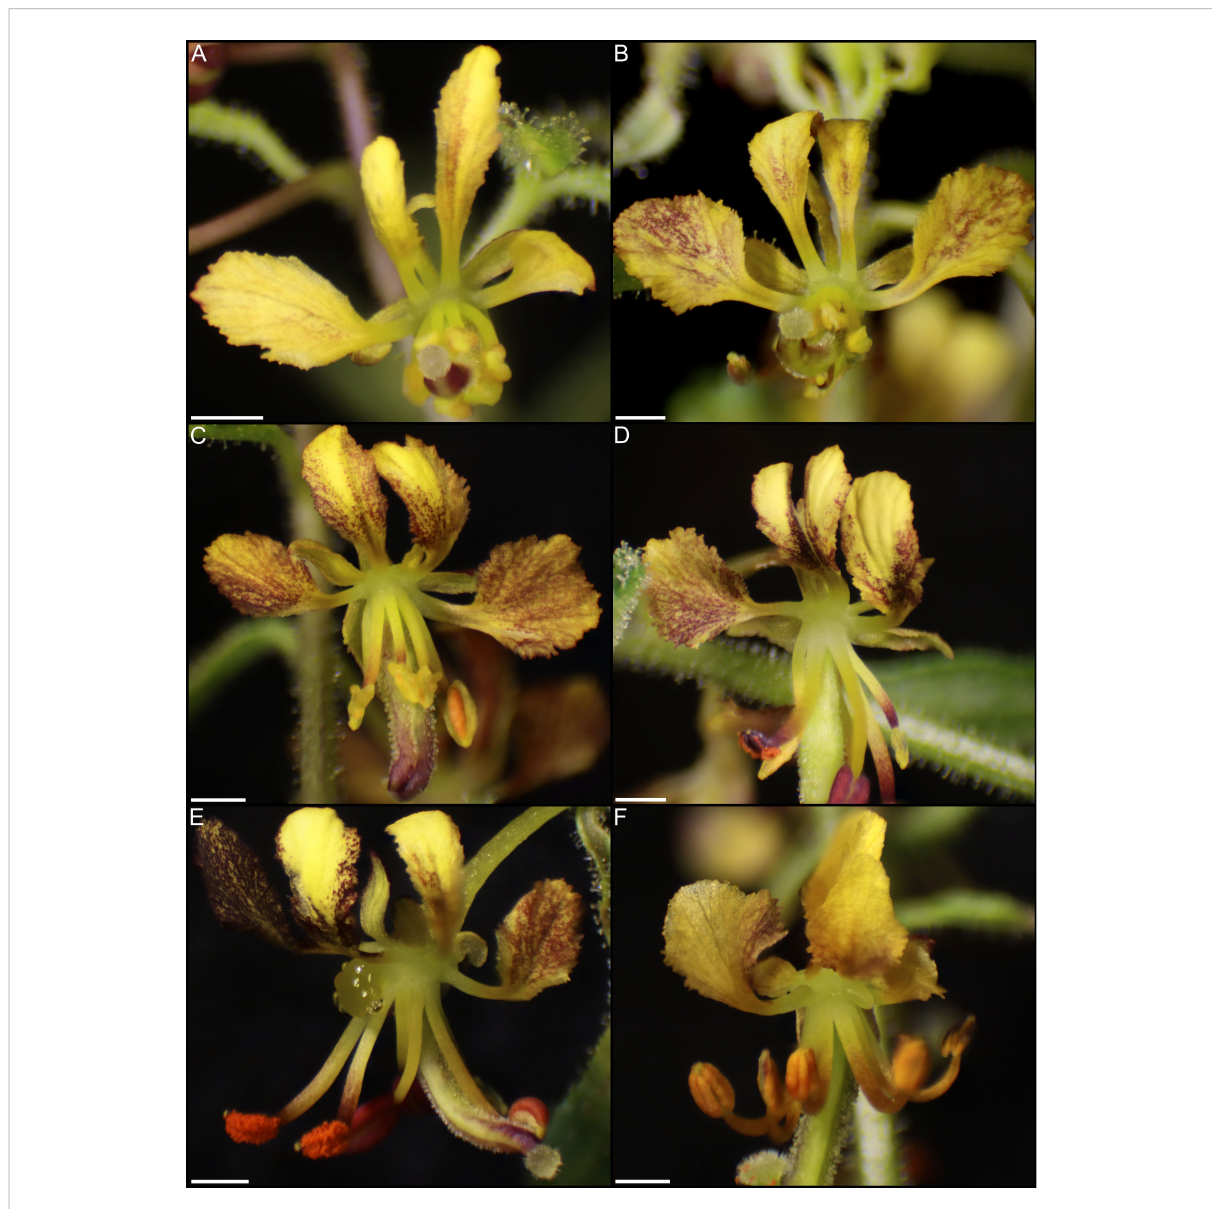
FIGURE 9 Flowers of Cleome violacea treated with pTRV2- CvCRC-CvANS constructs. (A) Flower with strong yellowing phenotype and no nectary. (B) Flower with moderate yellowing phenotype and no nectary. (C) Flower with moderate yellowing phenotype, no nectary, and enlarged gynoecium. (D) Flower with moderate yellowing phenotype and no nectary. (E) Flower with half normal and half yellowing petals with partially absent nectary. (F) Flower with strong yellowing phenotype and reduced lateral nectary lobes. Scale bars = 1